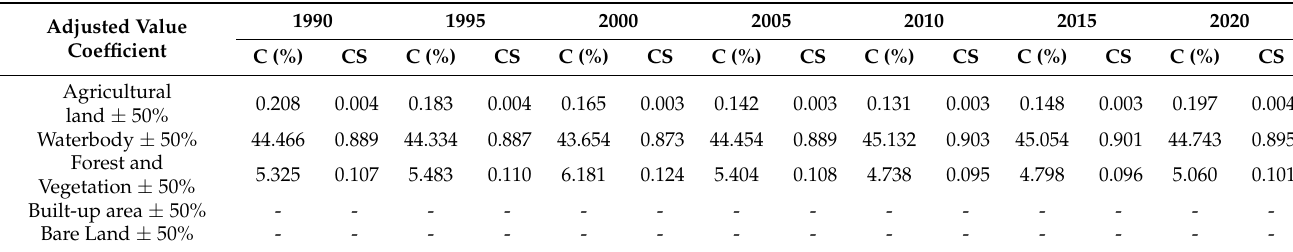
Table 11. Percentage change in estimated total ESV and coefficients of sensitivity (CSs) from an adjustment of ecosystem valuation coefficients (VC).